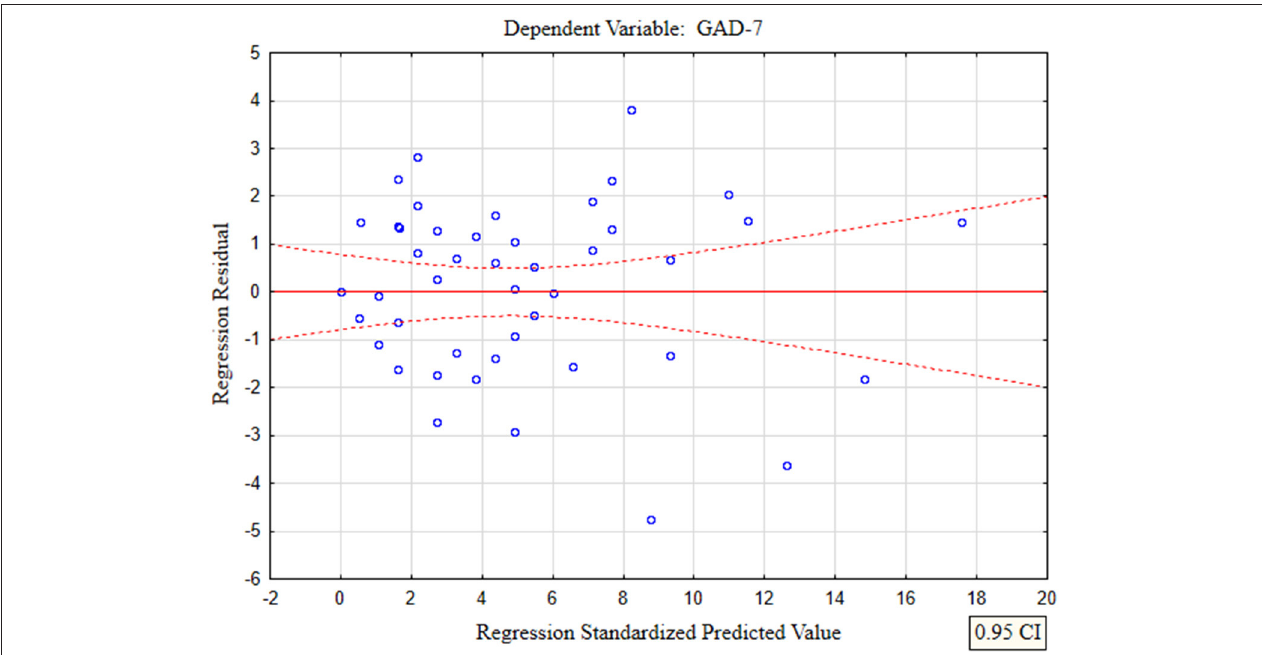
FIGURE 3 | The plot of standardized residues vs. standardized predicted values (homoscedasticity) with respect to multiple linear regression model for GAD-7